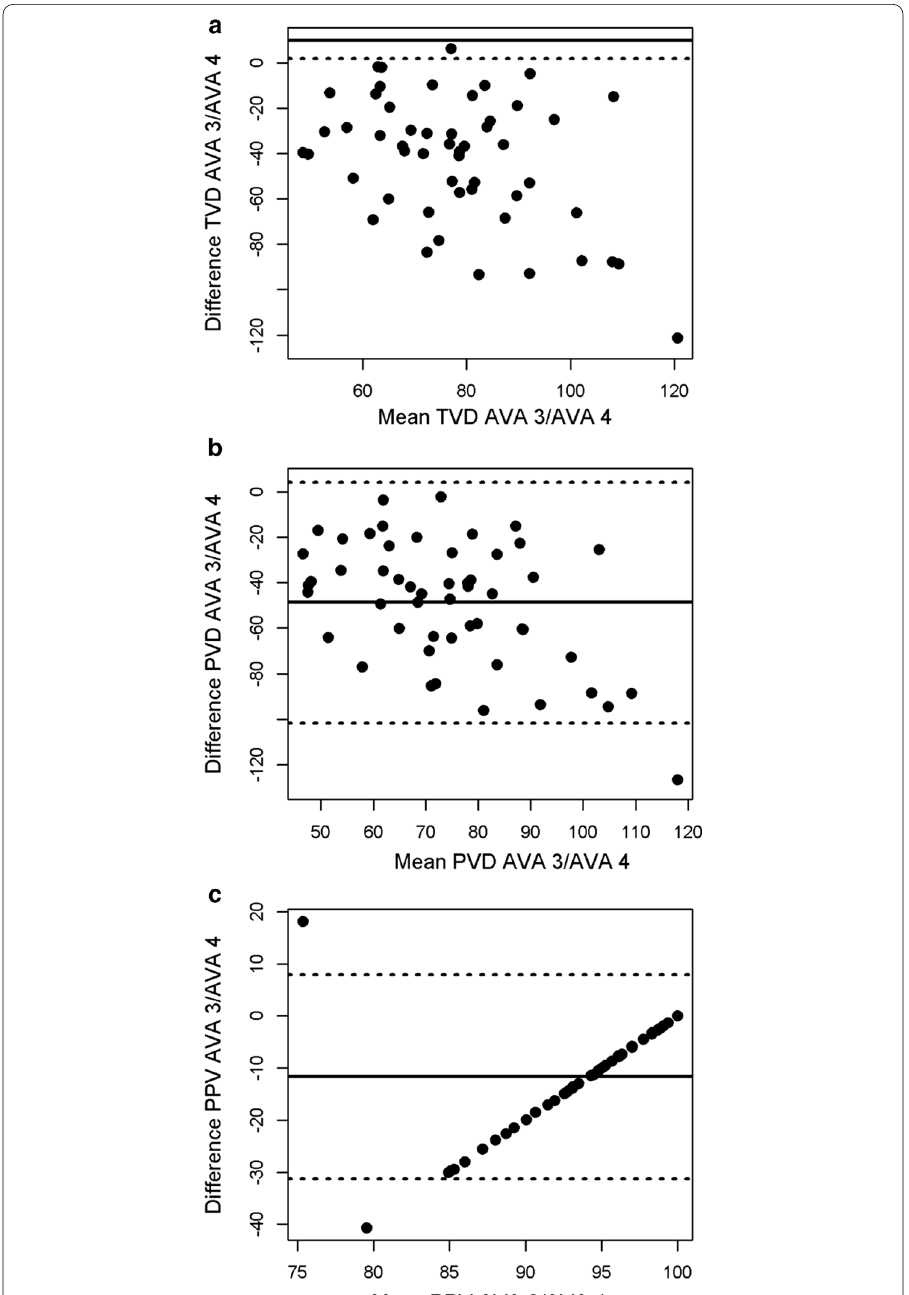
Fig. 1 P1 dataset Bland–Altman plots for total vessel density ( a ), perfused vessel density ( b ) and proportion of perfused vessels ( c ). The x -axis shows the mean of the two measurement methods and the y -axis shows their difference. The mean difference is represented by the solid line and the dashed lines represent the limits of agreement, equivalent to 1.96 SD of mean ±